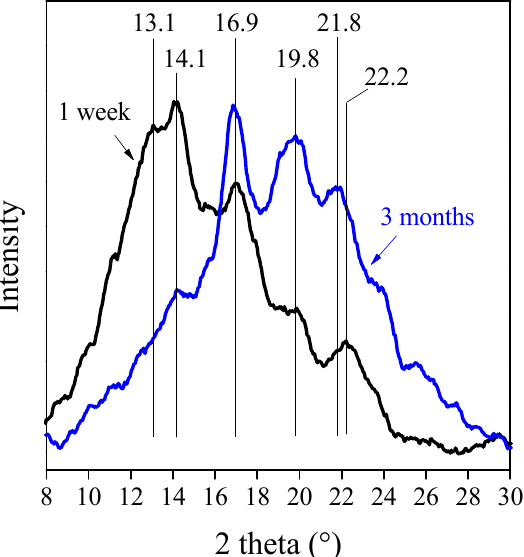
Figure 10. XRD diffractograms of TPS after 1 week and 3 months. Plasticizer: 40% Figure 10 . XRD diffractograms of TPS after 1 week and 3 months. Plasticizer: 40% glycerol.